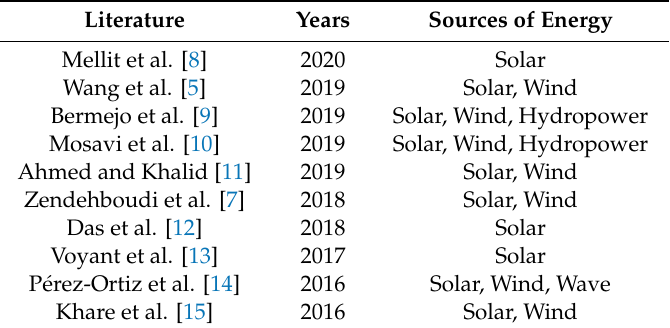
Table 1. Review studies of applying machine-learning techniques to renewable